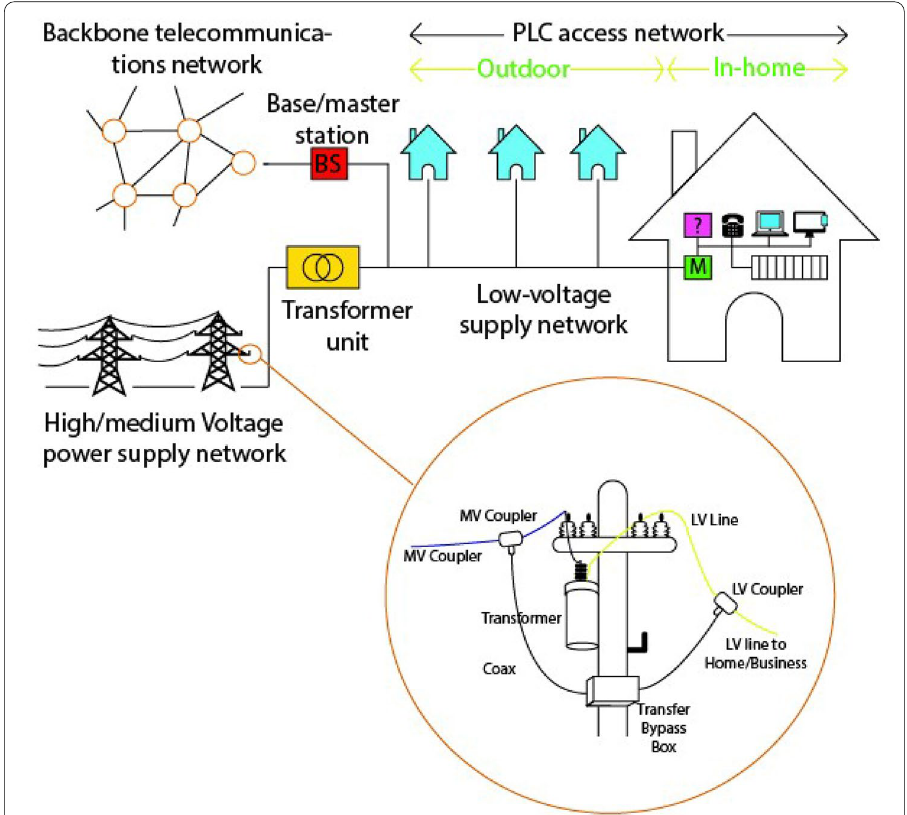
Fig. 1 Structure of power line communication